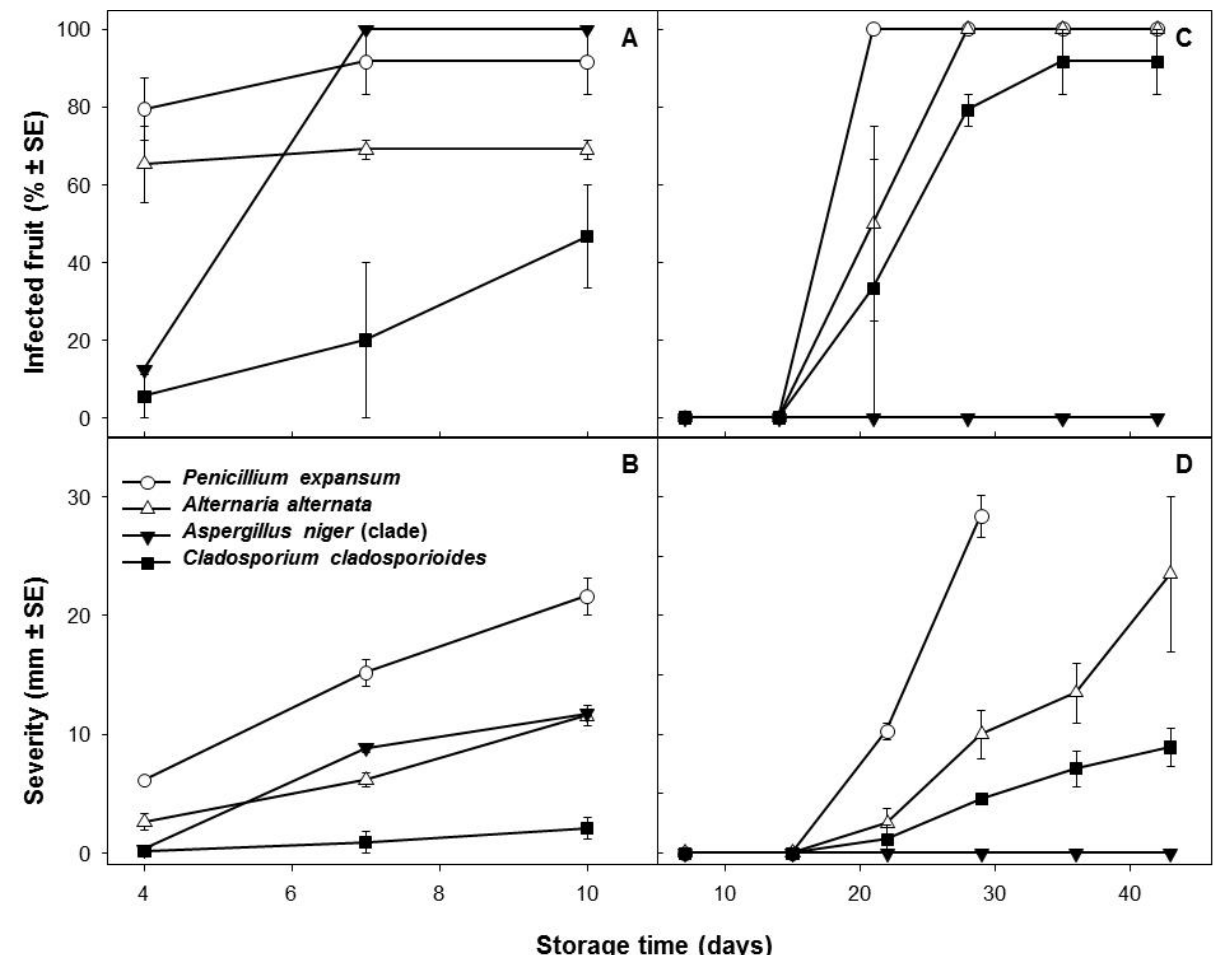
Figure 4 . Pathogenicity and disease development tests. Incidence (A and C) and severity (B and D) of postharvest diseases on ‘Medjool’ dates artificially inoculated with fungi isolated from naturally infected fruit. Inoculated fruit were incubated at 20ºC for 10 d (A and B) or cold-stored at 5ºC for up to 42 d (C and